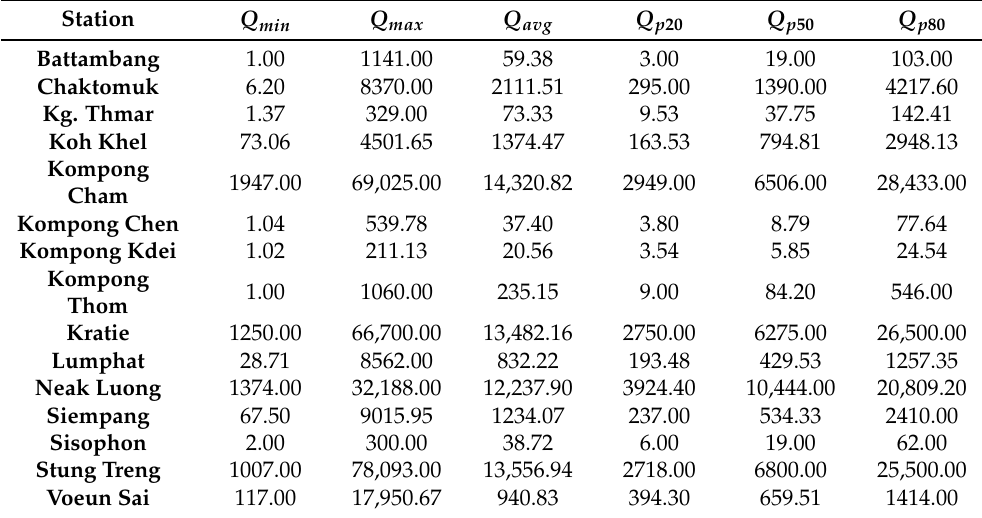
Table 3. The table lists the common discharge statistics for stations in Cambodia. The Q min is the minimum flow, Q max is the maximum flow, Q avg is the average flow, Q pn represents the n th percentile flow for the station across the timeseries. The unit of Q is m 3 /s.